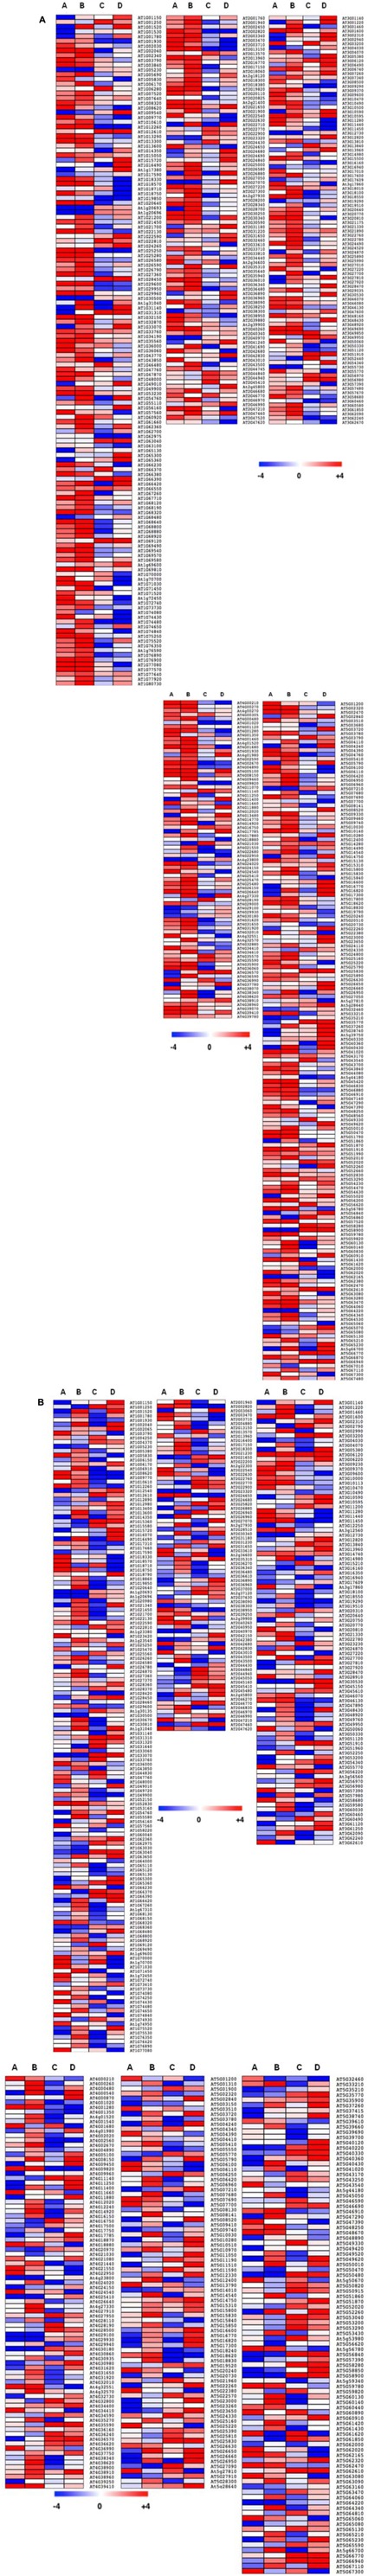
Effect of vitamin E deficiency on TFs profile under contrasting Pi availability. Heatmap showing the expression pattern of DETFs under varying Pi conditions in vte1/wild type (A) and vte4/wild type (B). Results for comparisons A–D, respectively, are shown from left to right. For each genotype and treatment, data was obtained from six individuals, using the mean of two independent measurements from three pooled plants each.